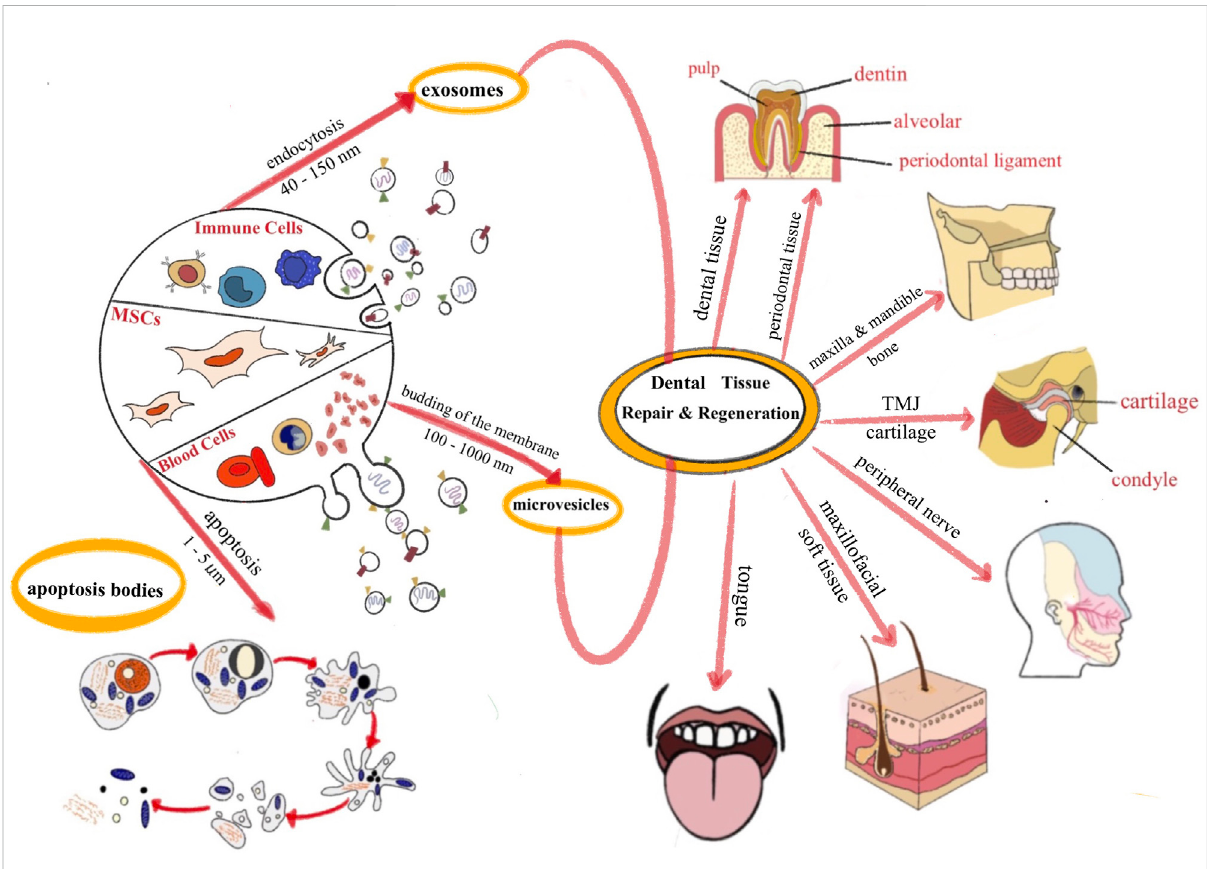
FIGURE 1 The application of EVs for dental and maxillofacial tissue repair and